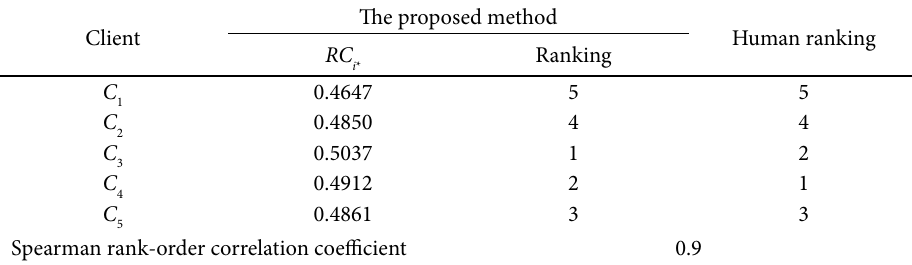
Table 8. Comparison of results between the proposed method and manual ranking for DM2